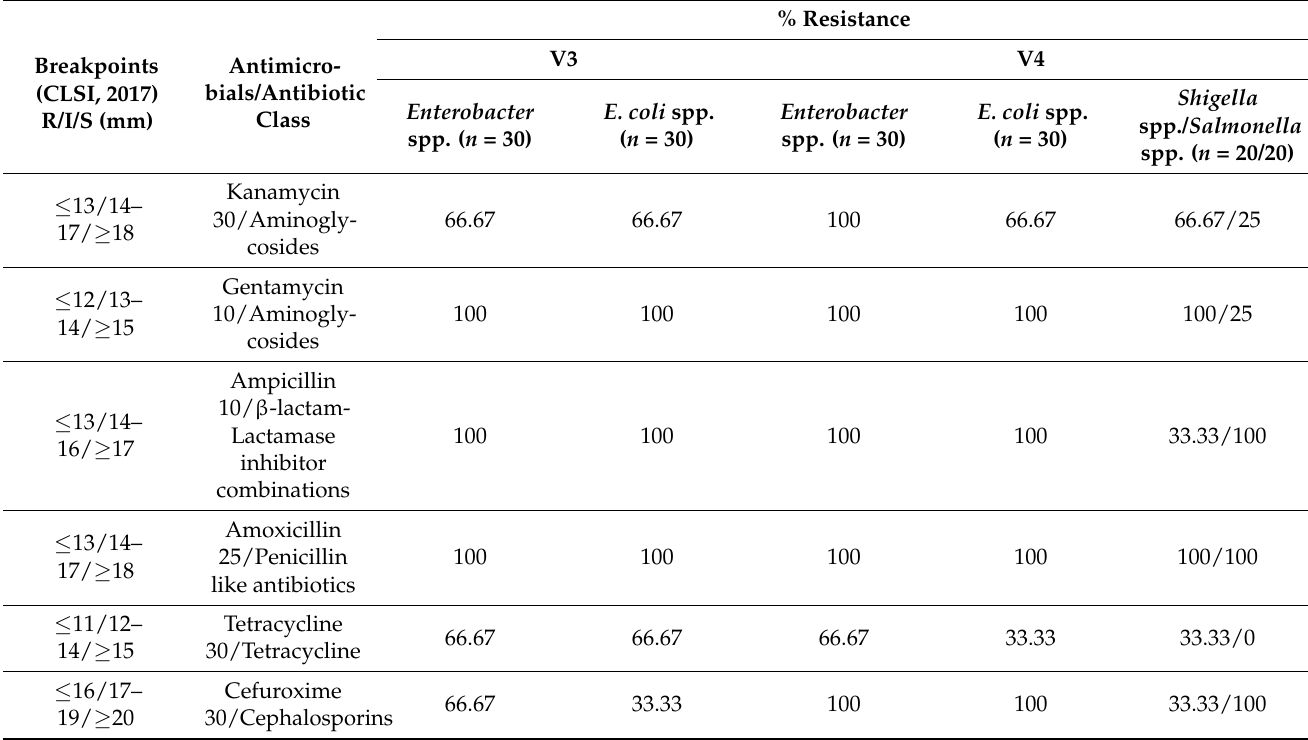
Table 3. Antimicrobial resistance (%) of isolates selected from mango ready-to-eat